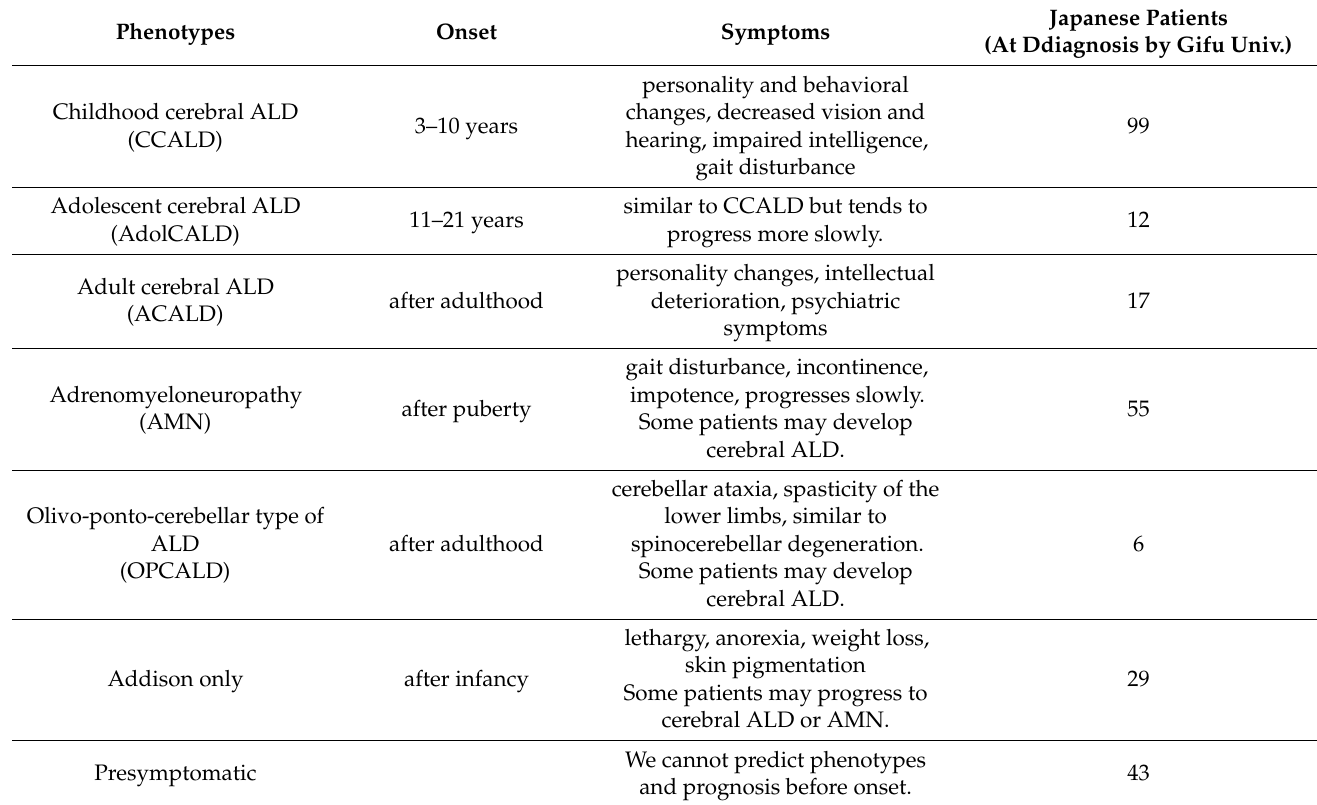
Table 1. Various phenotypes of